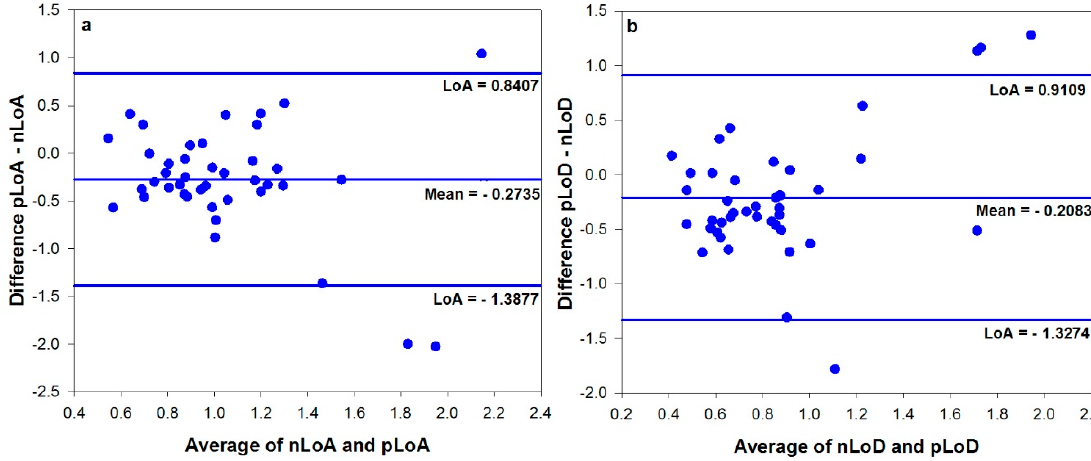
Figure 5. Bland and Altman plots of ( a ) novel Latency of Accommodation and previously used Latency of accommodation and ( b ) novel Latency of Disaccommodation and previously used Latency of Disaccommodation.